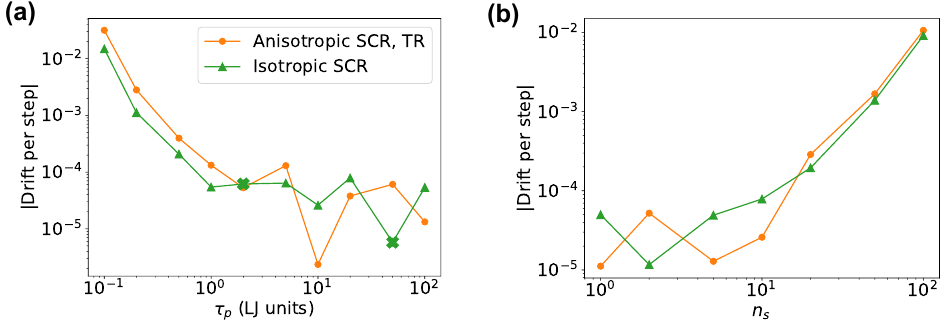
Figure 2. Effective energy drift for an fcc Lennard-Jones crystal simulated with SimpleMD. Results for both the isotropic and anisotropic versions are reported as a function of the barostat relaxation time τ P in panel ( a ) and as a function of the barostat stride in panel ( b ). TR denotes the time-reversible integrator (see Section 2.3.2). Absolute value is reported in the figure. The drift was positive for all the points, except for those marked with a cross, for which the drift was negative.